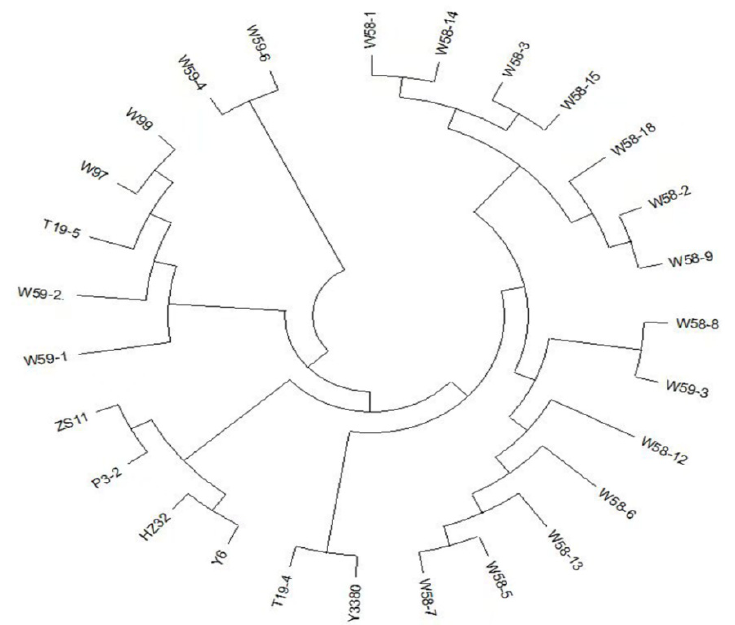
Figure 5. Genetic cluster analysis of parents, F 1 , F 2 , BC 1 F 1 , induced F 1 , the double haploid (DH) in- ducer. Parents: P3-2, ZS11, Y6, HZ32, F 1 : T19-4, T19-5; F 2 : W97, BC 1 F 1 : W99; induced F 1 : W58,